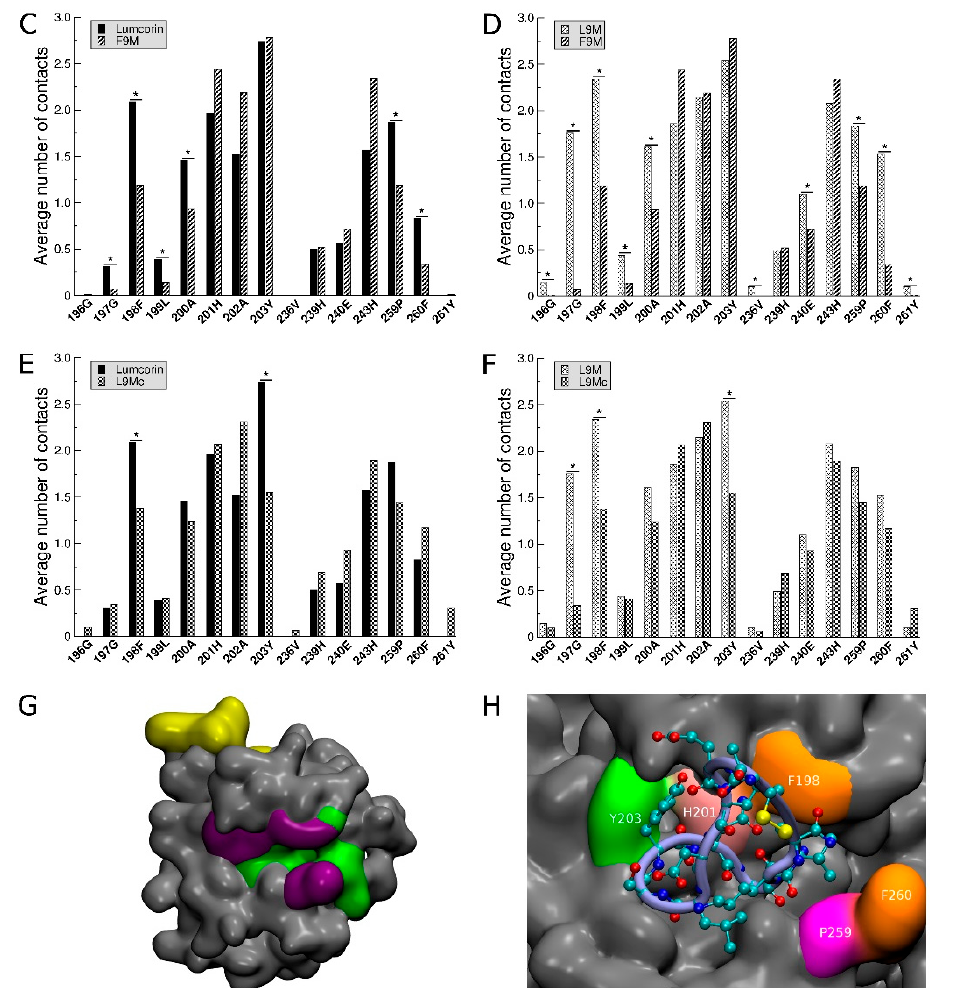
Figure 5. Pairwise comparison of the number of contacts between MMP-14 and different SLRP-derived peptides. The average numbers of contacts (hydrophobic or through hydrogen bonds) and their root mean square deviations computed over the 100 dockings were evaluated for each residue of the MMP-14 catalytic region. Panels ( A ) to ( D ) correspond to the training set of the protocol since inhibitory peptides (lumcorin and L9M) are compared to inactive peptides (D9M and F9M); panels A , B , C , and D display the comparison of lumcorin and D9M, L9M and D9M, lumcorin and F9M and L9M, and F9M, respectively. In the case of D9M and F9M, for which there is more than one representative structure (5 for D9M and 2 for F9M) extracted by the clustering analysis, all the conformations were compared to the representative structure of lumcorin and L9M. For clarity purposes, only the comparisons with the first cluster are presented. Panels E and F display the comparison of L9Mc with lumcorin and L9M, respectively. Error bars (root mean square deviations) are not represented on the different panels but were taken into account for the comparison of the number of contacts with the Student’s t -test. Stars identify the residues of MMP-14 displaying significant differences between the considered SLRP-derived peptide. Based on the comparison of the average number of contacts between peptides whose activity is known, key residues of the catalytic zone could be highlighted (panel G , violet surface), and docking solutions associated with L9Mc situated in the catalytic zone evidenced contacts involving some of these key residues (panel H ). *, p <